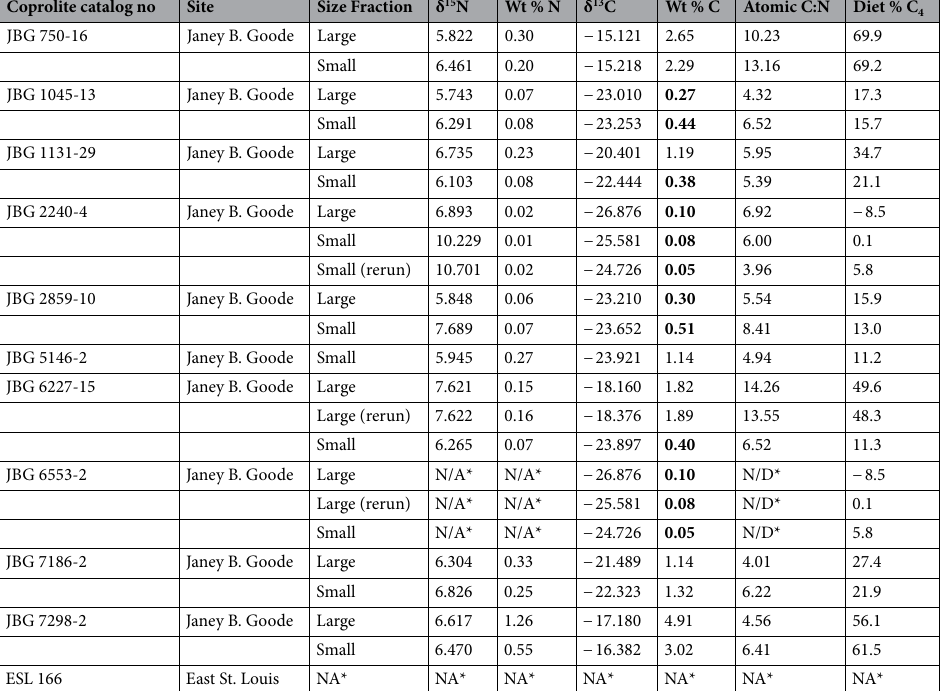
Table 2. Coprolite elemental and isotopic composition. δ 15 N and δ 13 C values are listed for the large and small fractions of each coprolite, as well as weight percent N and C and the atomic C:N ratio. N/D* indicates that the nitrogen concentration was below peak detection limits, so C:N could not be calculated. Only the small fraction for 5146-2 was available for analysis. Samples with less than 1% C are indicated in bold font. Diet % C 4 is calculated assuming δ 13 C end member values of − 26.5‰ and − 11.5‰ for 0% and 100% C 4 , respectively, and a diet-feces difference of − 0.9‰. NA* indicates that the coprolite sample from East St. Louis was not available for stable isotope